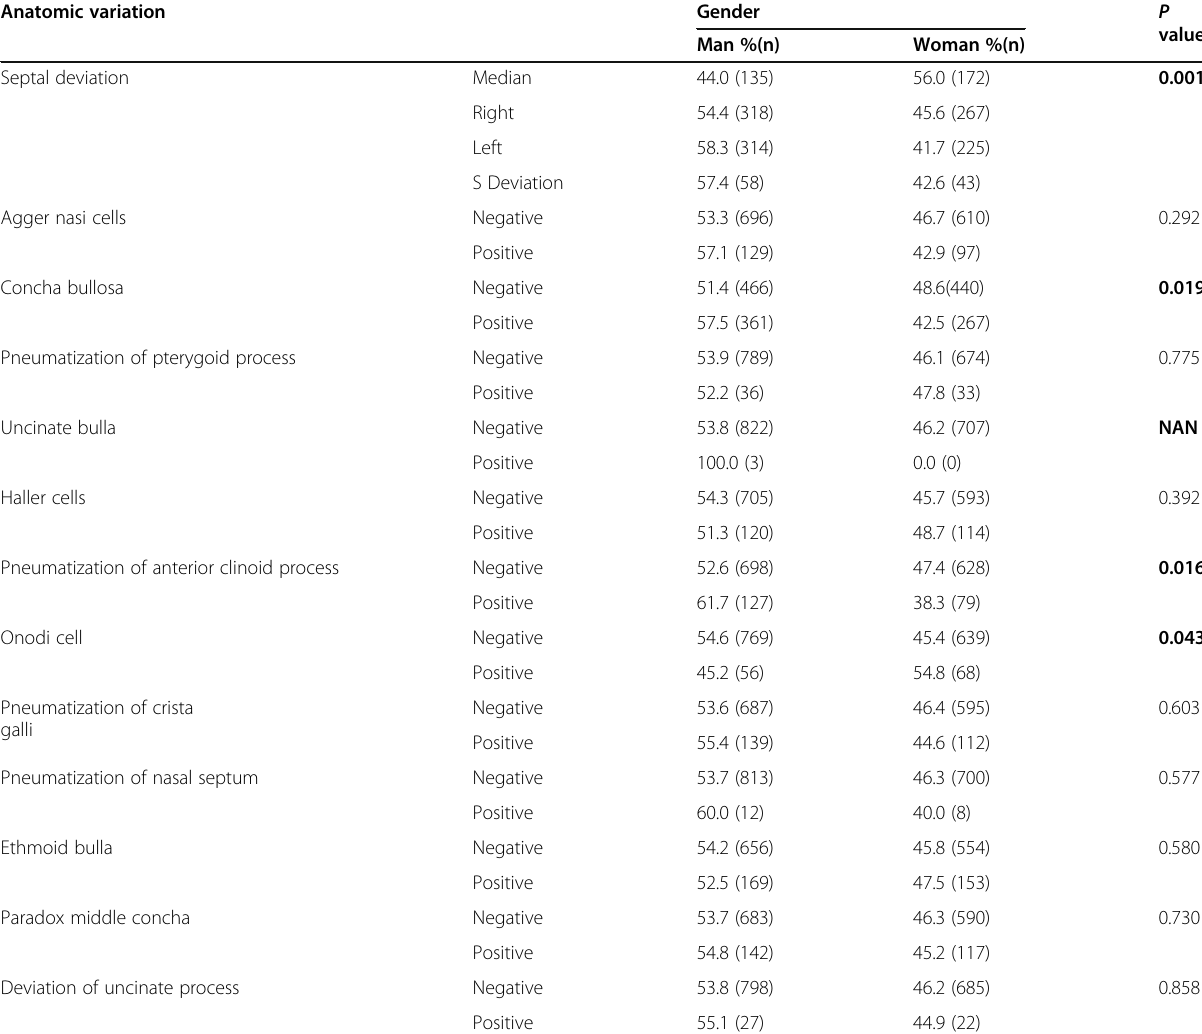
Table 1 The gender distribution of the paranasal CT scans Anatomic